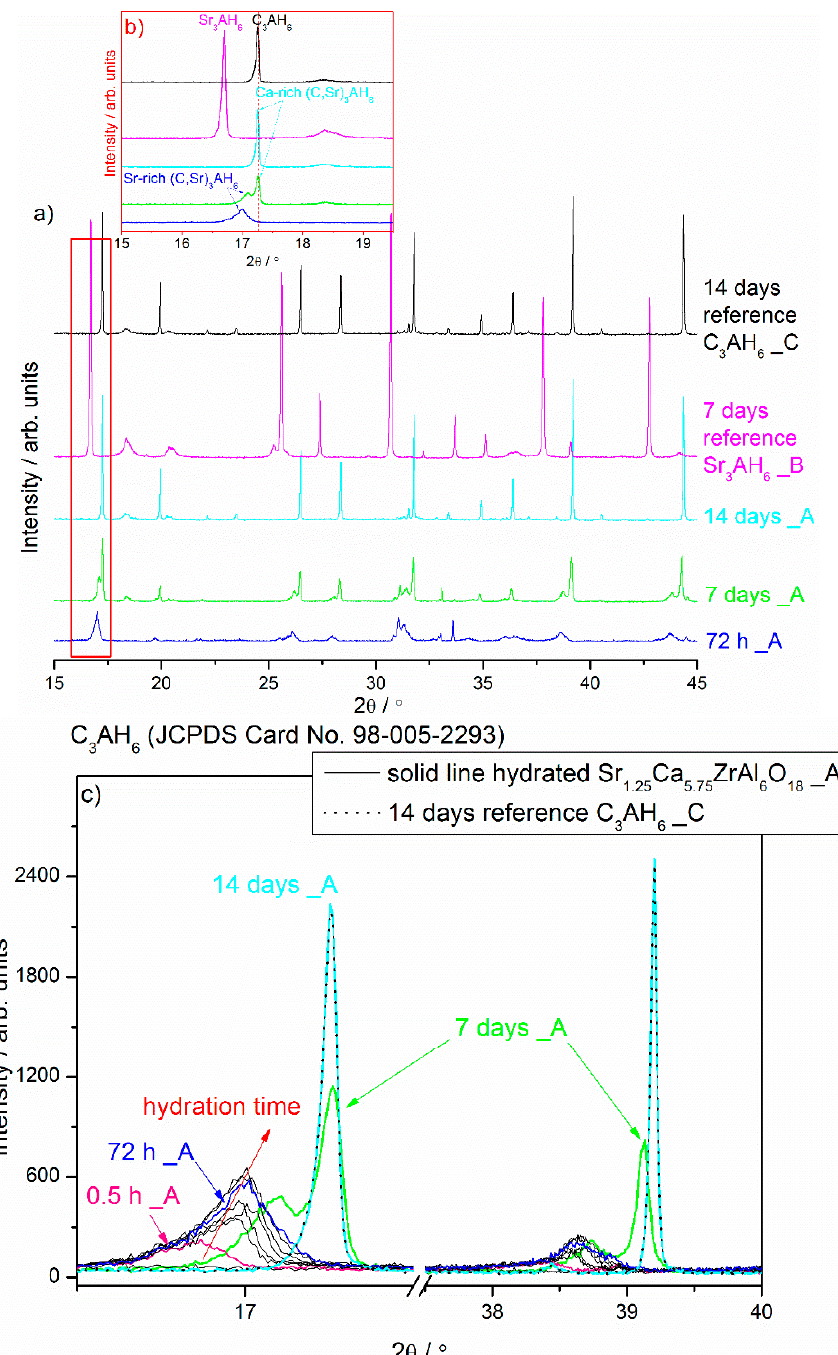
Figure 1. X-ray diffraction patterns of the Sr 1.25 Ca 5.75 ZrAl 6 O 18 cement paste (Sample A) at different curing periods. ( a , b ) contains lines of two reference materials, i.e., Sr 3 AH 6 synthesized through hydration from SrAl 2 O 4 cement (Sample B) and C 3 AH 6 synthesized through hydration from Ca 7 ZrAl 6 O 18 cement (Sample C). ( c ) contains a line (dot line) of the reference C 3 AH 6 formed at 14 d (Sample C).